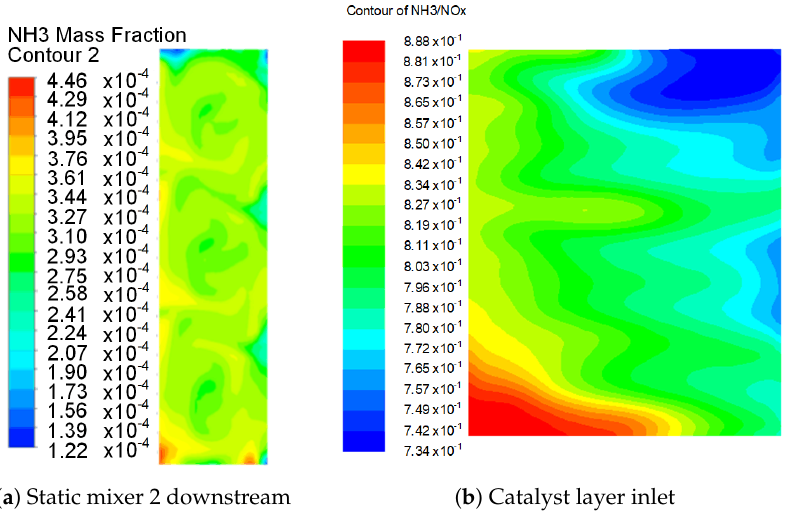
Figure 11. Concentration filed with static mixer 2. ( a ): Distribution diagram of ammonia concentra- tion in the downstream section of static mixer. ( b ): Distribution diagram of ammonia nitrogen mole ratio of section in front of the catalyst